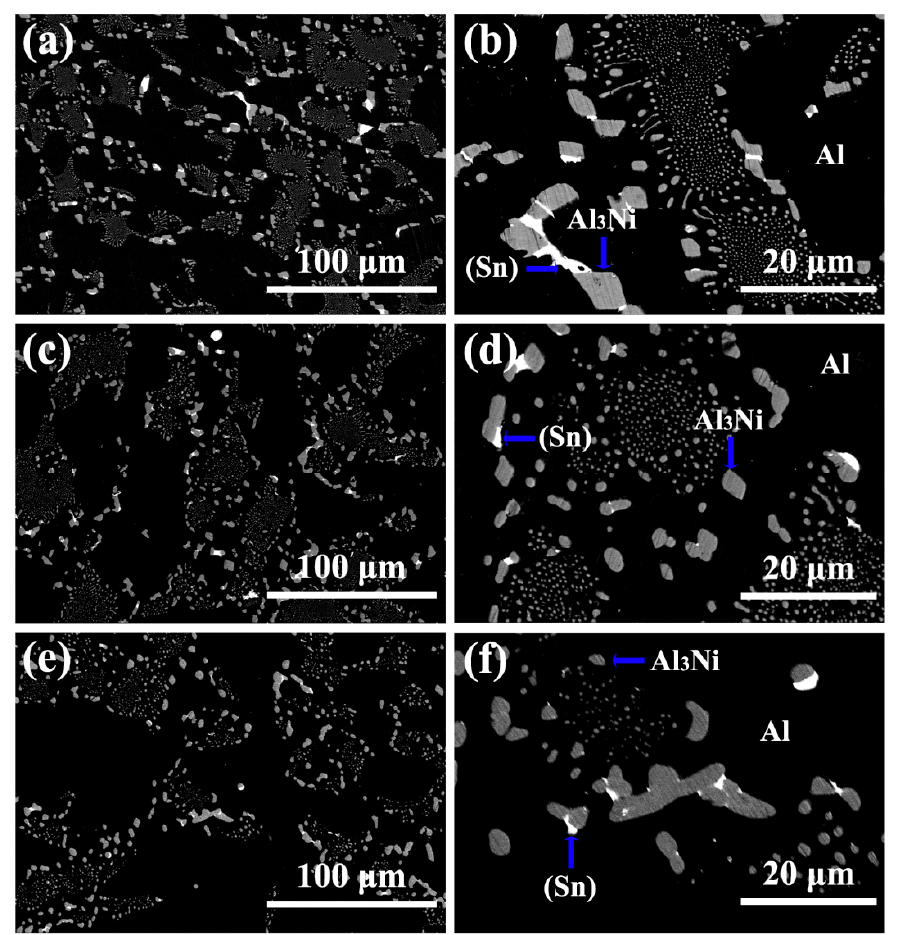
Figure 2. The microstructure of Al-5.4Ni-2Sn alloy solidified under different pressures. ( a , b ) Ambient pressure, ( c , d ) 2 GPa, ( e , f ) 4 GPa.